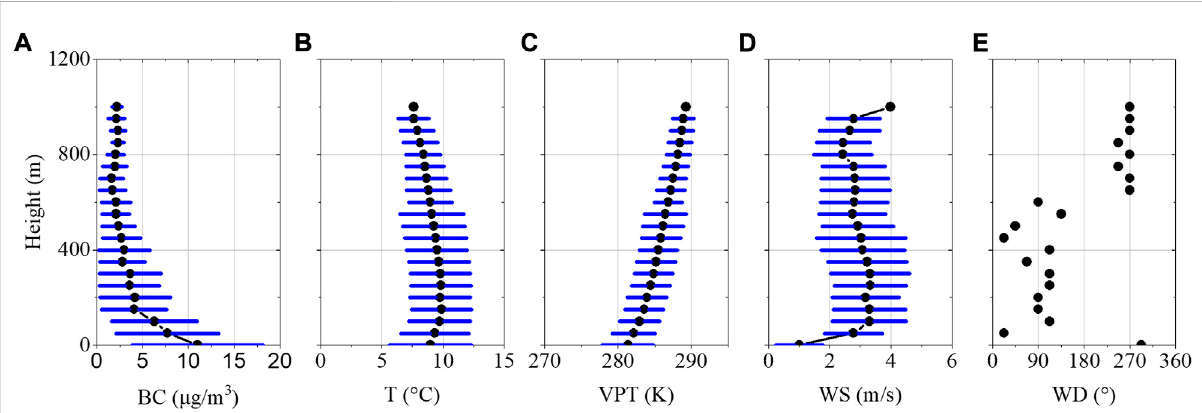
FIGURE 3 During winter observation period, BC, T, VPT, WS and WD contours. Blue lines are BC standard deviation line. (A) black carbon aerosol vertical pro fi le, (B) temperature vertical pro fi le, (C) virtual potential temperature vertical pro fi le, (D) wind speed vertical pro fi le, (E) wind direction vertical pro fi le.